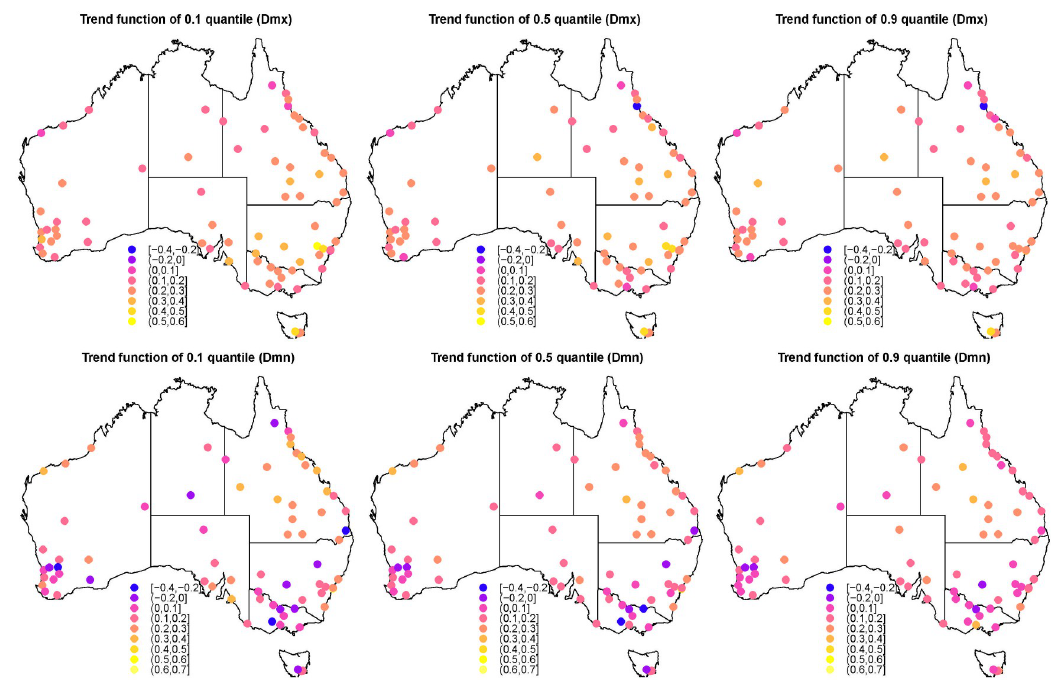
Fig 3. Quantile trend of τ = 0.1, 0.5 and 0.9 for all 72 stations during the study period. The color of point is the total degrees Celsius that increased/decreased per decade from 1960 to 2019. The top panels are for the Dmx series and the bottom panels are for the Dmn